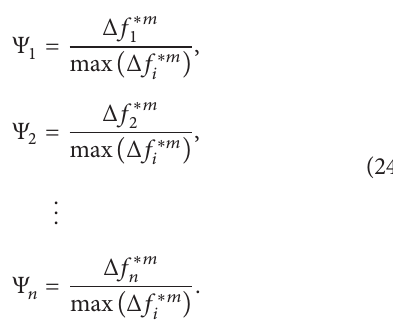
by dividing them by the highest value of the series.